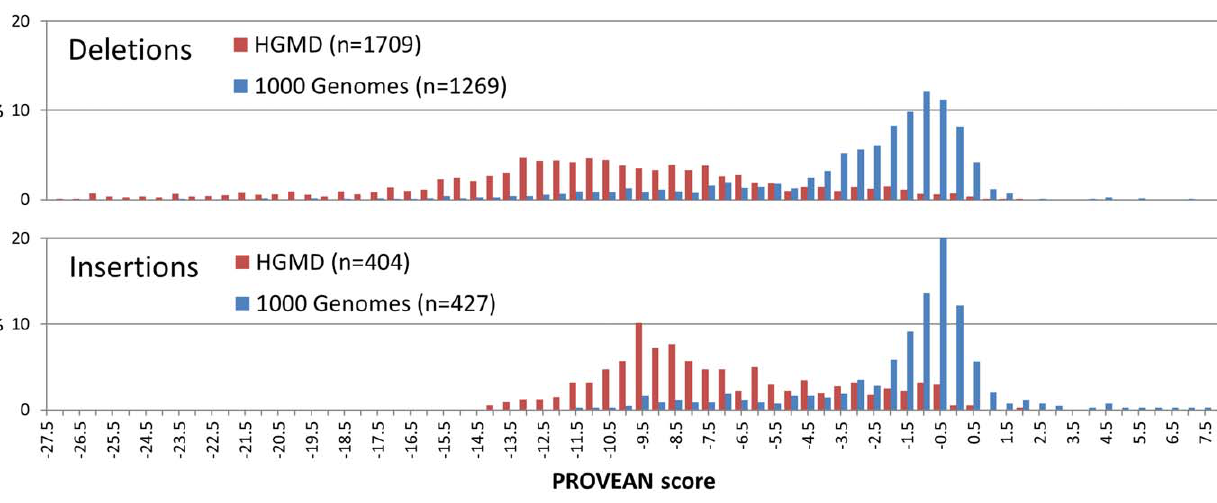
Figure 4. PROVEAN score distribution of deletions and insertions collected from the Human Gene Mutation Database (HGMD) and the 1000 Genomes Project. Only mutations annotated as ‘‘disease-causing’’ were collected from the HGMD. The distribution shows a distinct separation between the two datasets. doi:10.1371/journal.pone.0046688.g004 PLOS ONE |